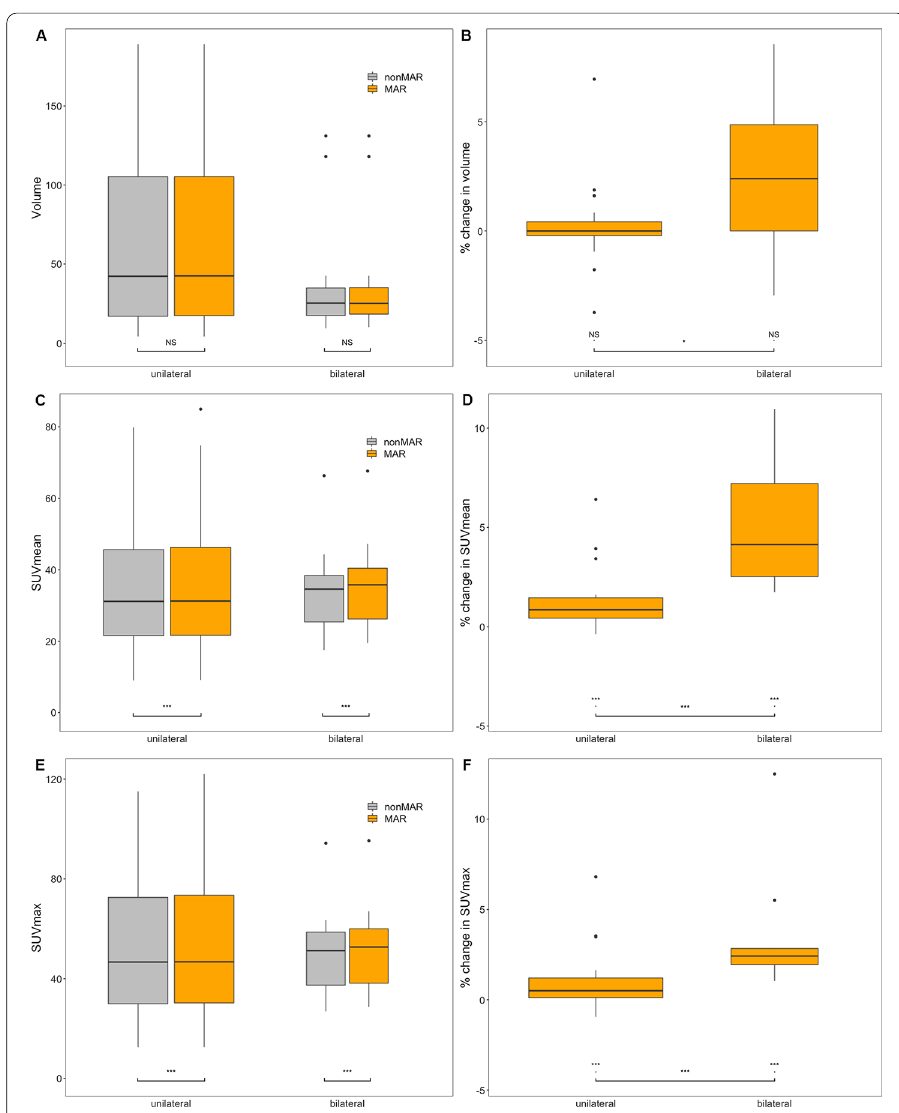
Fig. 10 Bladder measurements. Panels A , C and E are boxplots describing the volume, SUV mean and SUV max of the bladder, according to the presence of unilateral or bilateral hip prostheses and to the use of MAR CT for attenuation correction. Panels B , D and F are boxplots describing the percentual changes of the measured volume, SUV mean and SUV max induced by MAR. Boxes and whiskers are as in Fig. 7. The width of the boxes is proportional to the square root of the number of observations. Statistical significance of the difference with use of MAR is indicated in panels A , C and E ; in panels B , D and F it is indicated whether the percentual increase in SUV differs significantly from 0 (NS denotes not significant, * p < 0.05, ** p < 0.01, *** p <